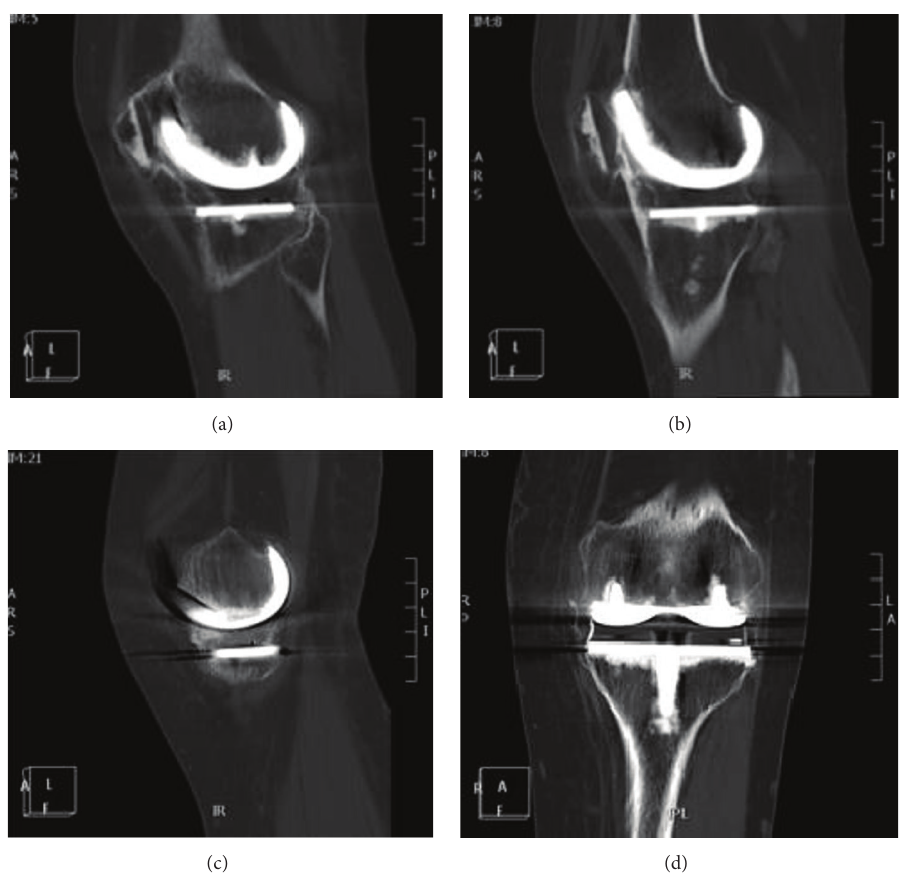
Figure 2: CT scan views showing a circumferential complete ankylosis of the knee.